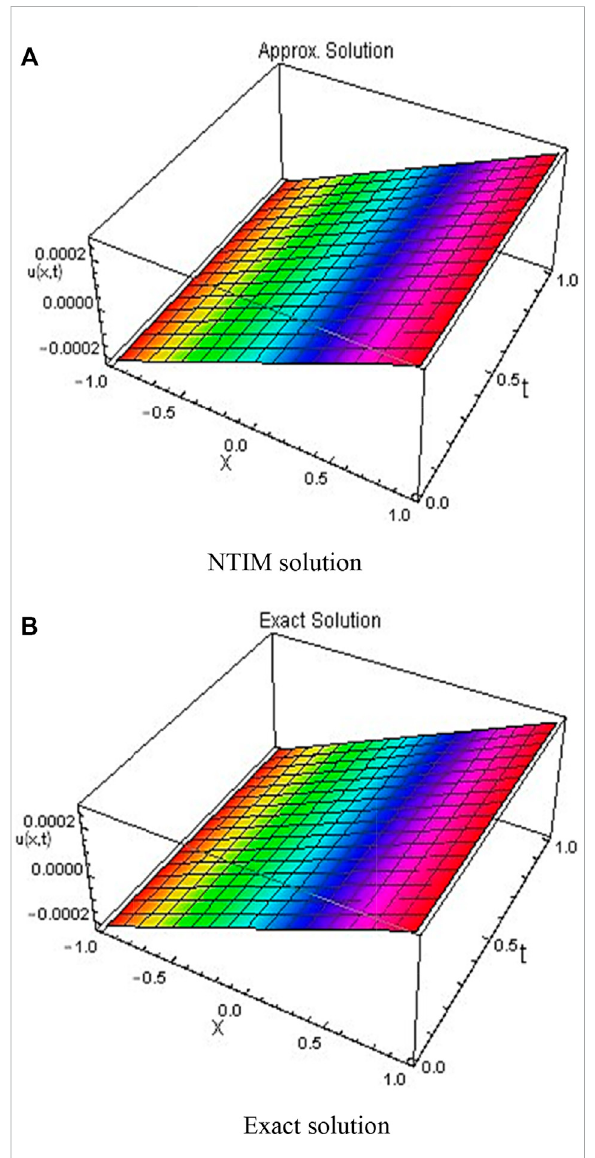
FIGURE 4 3D plots obtained by the fi rst order (A) NTIM and (B) exact solution for β (cid:2) 1 . 0 , y (cid:2) 0 . 1 , λ (cid:2) 0 . 001 for Example 3.3.